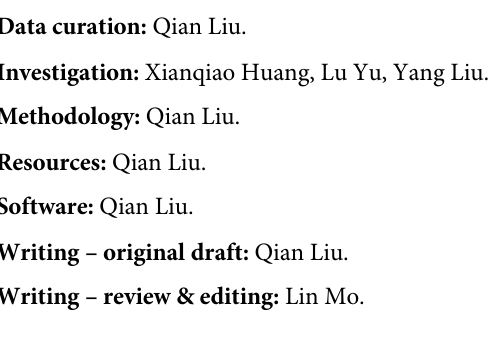
S1 Fig. The first model of behavior problems among 8~18 years old children with malig- nant tumors. S2 Fig. The second model of behavior problems among 8~18 years old children with malig- nant